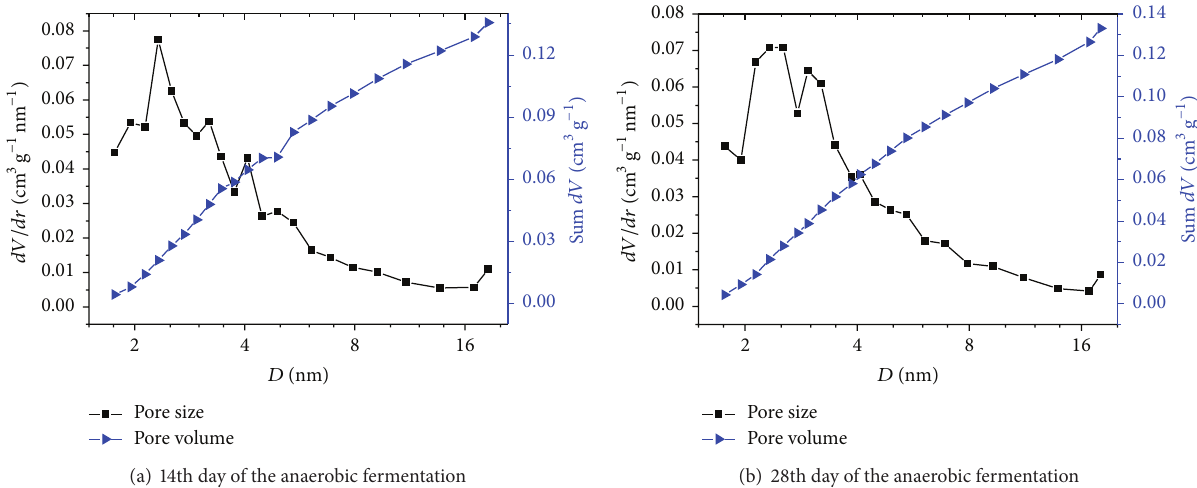
Figure 7: The distribution curve of pore volume and pore size of sample I.